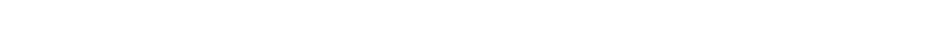
Frontiers in Oncology | Pharmacology of Anti-Cancer